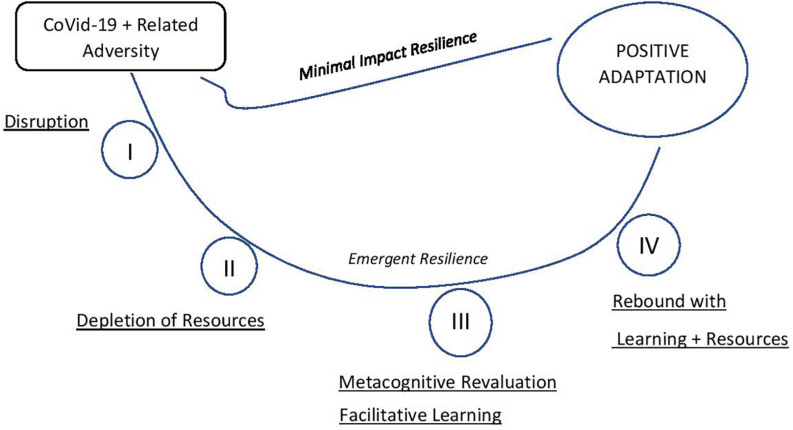
Model of resilience trajectories adapted to COVID-19 (adapted from Bonanno and Diminich, 2013; Gupta and McCarthy, in press).